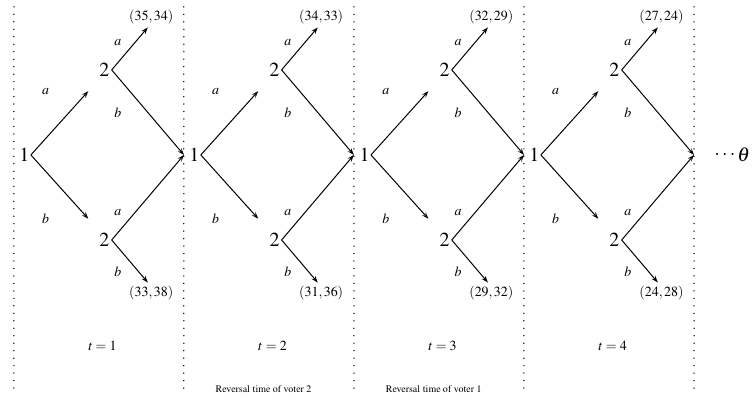
Figure 1. Example of fixed order